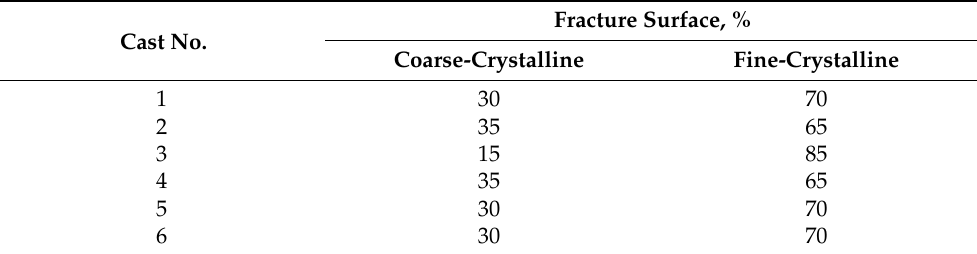
Fracture Surface,